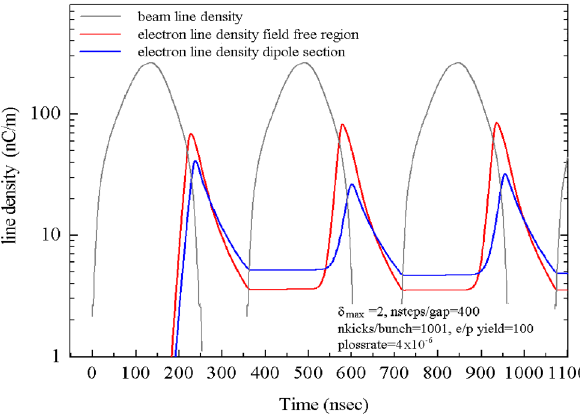
FIG. 3. (Color) Simulated electron density during the first bunch passages, in a PSR field-free region and a dipole section. The saturation level is reached after a few bunch